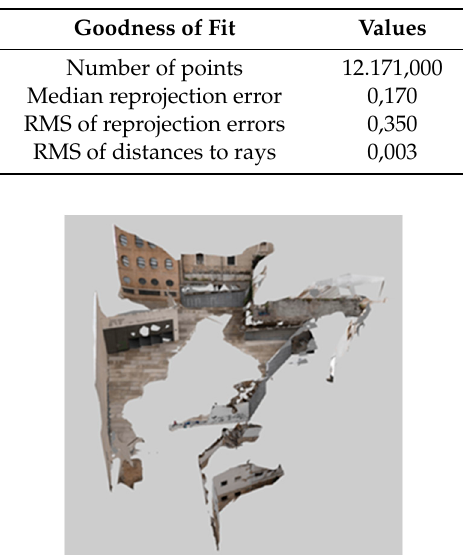
Figure 5. Digital model B’ obtained with terrestrial photogrammetry.